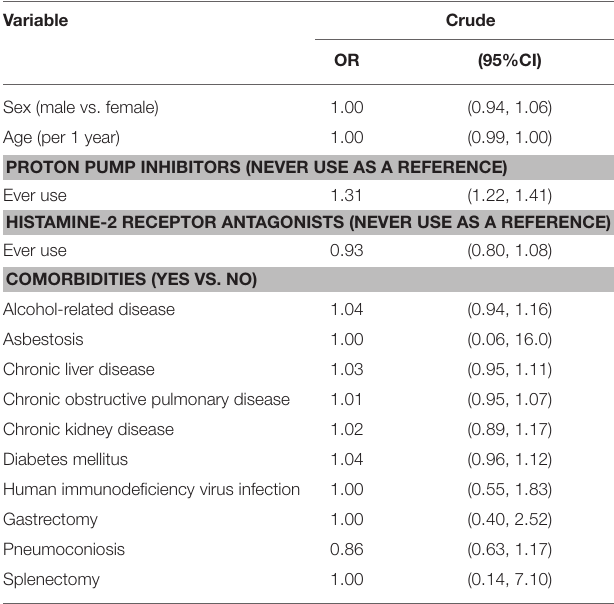
TABLE 2 | Odds ratio and 95% confidence interval of pulmonary tuberculosis associated with proton pump inhibitors use and comorbidities. Variable Crude